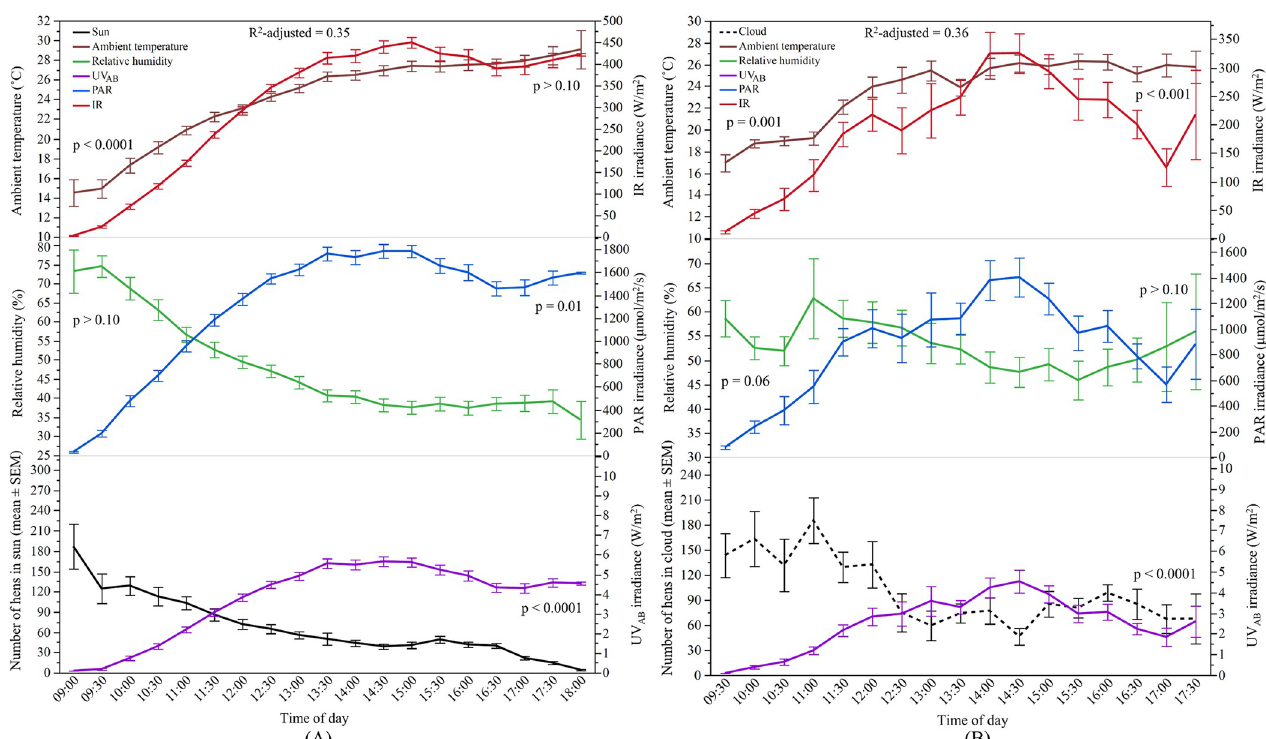
Fig 10. Relationship between sunlight spectrums and weather variables with the number of hens in the ‘sun’ and ‘cloud’ in WA: (A) Y-axis (left): The mean ( ± SEM) number of hens in the ‘sun’, and the mean ( ± SEM) relative humidity and ambient temperature; Y-axis (right): the mean ( ± SEM) irradiance of UV AB (ultraviolet radiation A and B wavelengths), PAR (photosynthetically active radiation), and IR (infrared radiation); (B) Y-axis (left): The mean ( ± SEM) number of hens in the ‘cloud’, and the mean ( ± SEM) relative humidity and ambient temperature; Y-axis (right): the mean ( ± SEM) irradiance of UV AB (ultraviolet radiation A and B wavelengths), PAR (photosynthetically active radiation), and IR (infrared radiation). p > 0.10 indicates the variable had no significant effect and was removed from the final